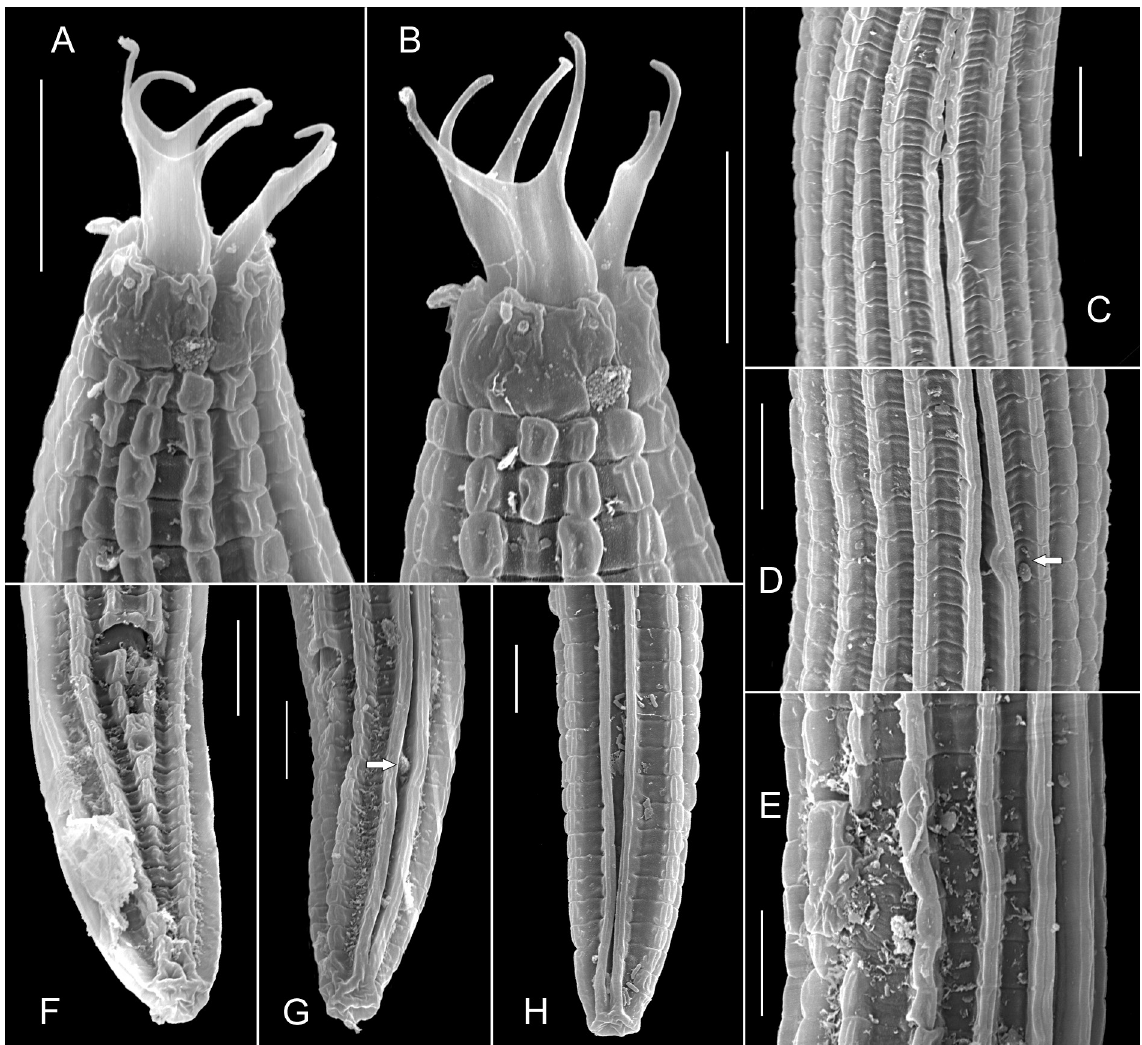
Fig. 2. Stegelleta incisa (Thorne, 1937), SEM micrographs. A–B . Anterior end, left lateral view. C . Anterior part of lateral field. D . Deirid (arrow). E . Vulval region. F . Female tail, subventral view. G . Female tail, left sublateral view (arrow points at phasmid). H . Female tail, lateral view. Scale bars = 5